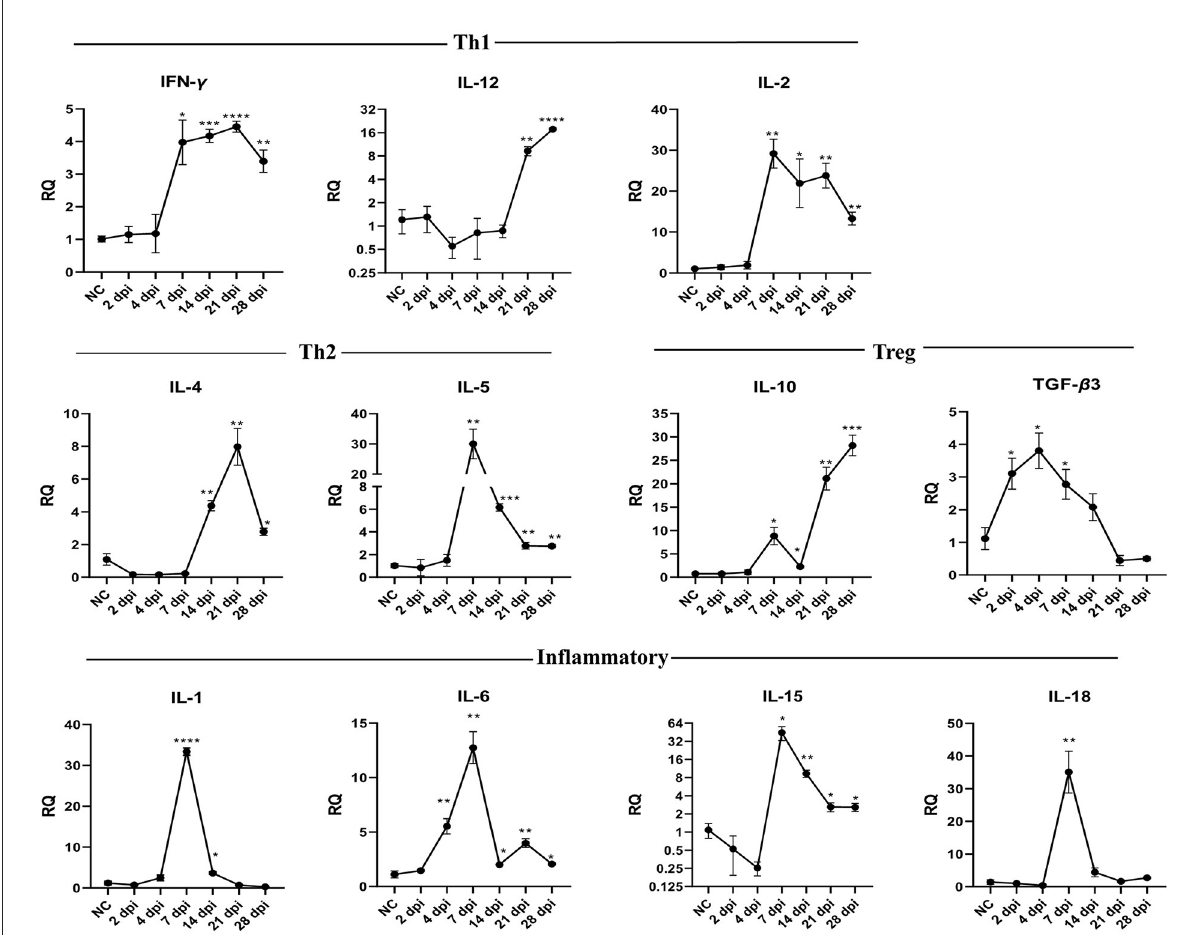
FIGURE5 Temporal changes of the cytokine mRNA expressions in the intestine of pigeons experimentally infected with Prohemistomum vivax. The X-axis represents days post-infection (dpi), and NC refers to negative control uninfected pigeons. The Y-axis represents relative quantities (RQ) of cytokine expression after normalization with β -actin based on the 2 − 11 CT method. Error bars show SEMs. Significant differences between each time-point and negative control (NC) uninfected group: * p < 0.05; ** p < 0.01; *** p < 0.001, or **** p < 0.0001 (using Student T -test).